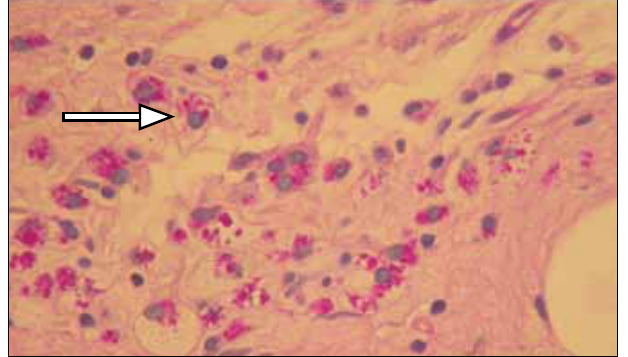
Fig 8. Periodic acid Schiff’s stain showing intracytoplasmic yeast cells (arrow).